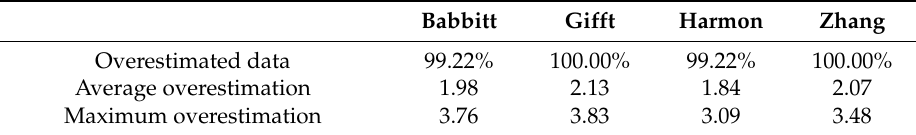
Table 5. Overestimation of peak hour factor using literature